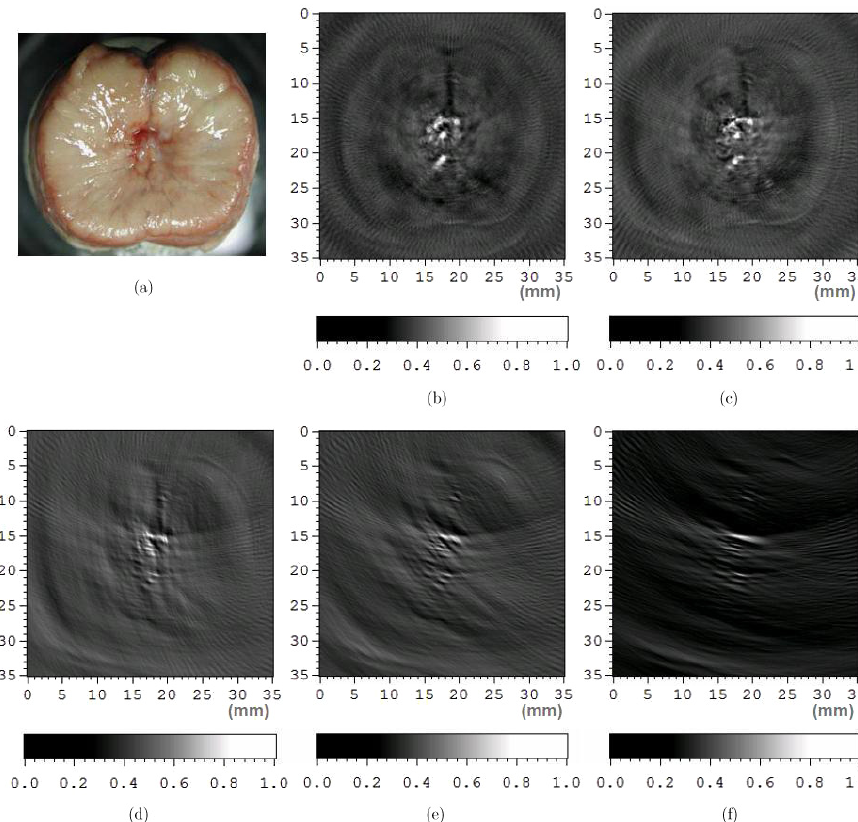
Source : © 2010 Optical Society of America. Reproduced, with permission, from Ref. 58. Fig. 3. Ex vivo 2D photoacoustic tomography of an excised canine prostate. (a) Anatomic photography of the prostate cross- section; (b) PA image acquired with a detection view angle of 360 (cid:1) . The PA image adequately illustrates the structural outline of the prostate and the urethra in the center. (c) – (f) PA images acquired with detection view angles of 180 (cid:1) , 90 (cid:1) , 60 (cid:1) and 30 (cid:1) . Wavelength of incident light ¼ 710 nm; pulse width ¼ 5 ns; pulse frequency ¼ 10 Hz.